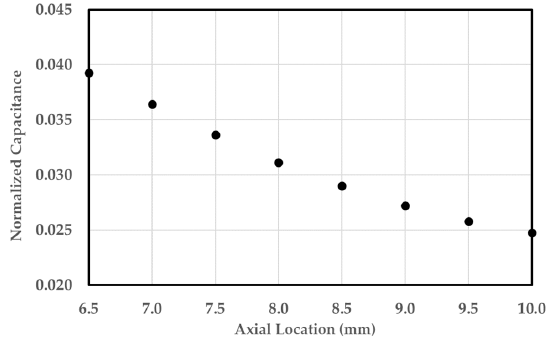
Figure 12. Effect of the axial location of the bubbles on the normalized capacitance.